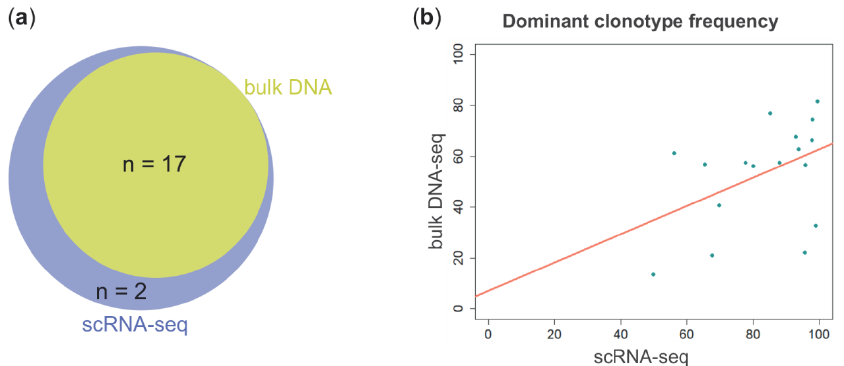
Figure 2. ( a ) Venn diagram showing the number of unique and shared clonotypes between scRNA-seq (blue circle) and bulk DNA (yellow circle) analyses. ( b ) Scatterplot of the percentage frequencies of the 17 dominant clonotypes in ( a ) as determined by scRNA-seq ( x axis) and bulk DNA-seq ( y axis) analyses. Table 1. Comparison of V(D)J clonal rearrangements at IGH locus identified by scRNA-seq and amplicon-based NGS from bulk DNA in the 17/19 samples in which the two methods gave matching